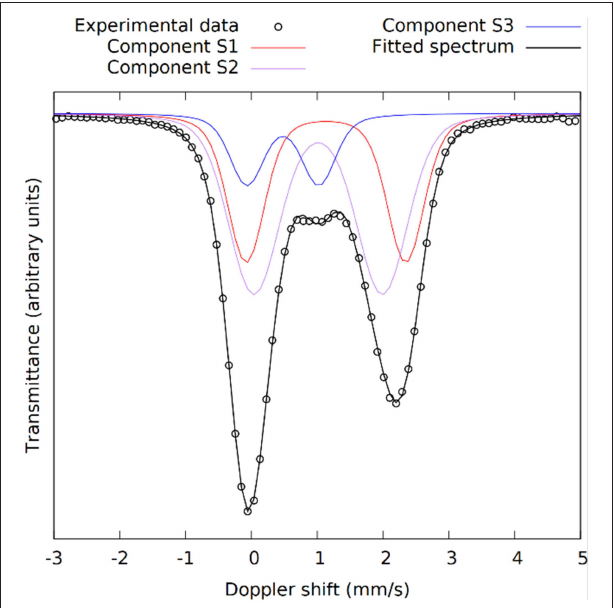
FIGURE 3 | The 57 Fe Mössbauer spectrum of the slag with the three components used in the fitting model shown in different colors. S1 and S2 are Fe 2 + and S3 is Fe 3 +